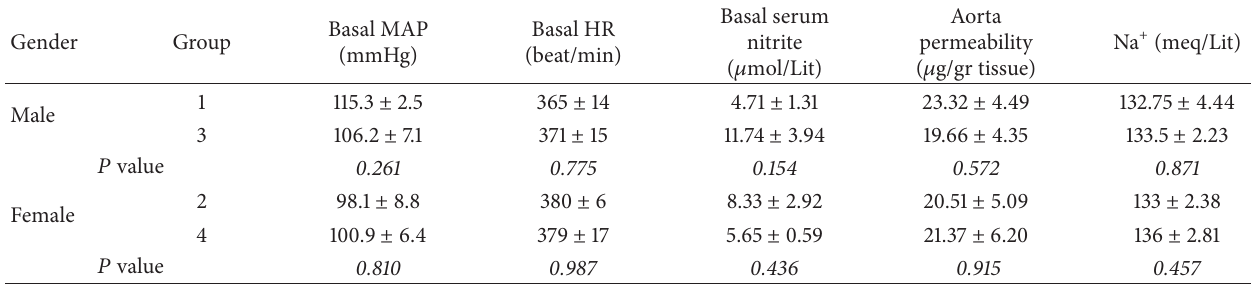
Table 2: Basal values of MAP, HR, serum nitrite, Na + , and aorta permeability in male and female offspring (adult). Groups 1 and 2: male (group 1) and female (group 2) offspring from mothers who received tap water during pregnancy. Groups 3 and 4: male (group 3) and female (group 4) offspring from mothers who received high-salt water during pregnancy. Basal Gender Group